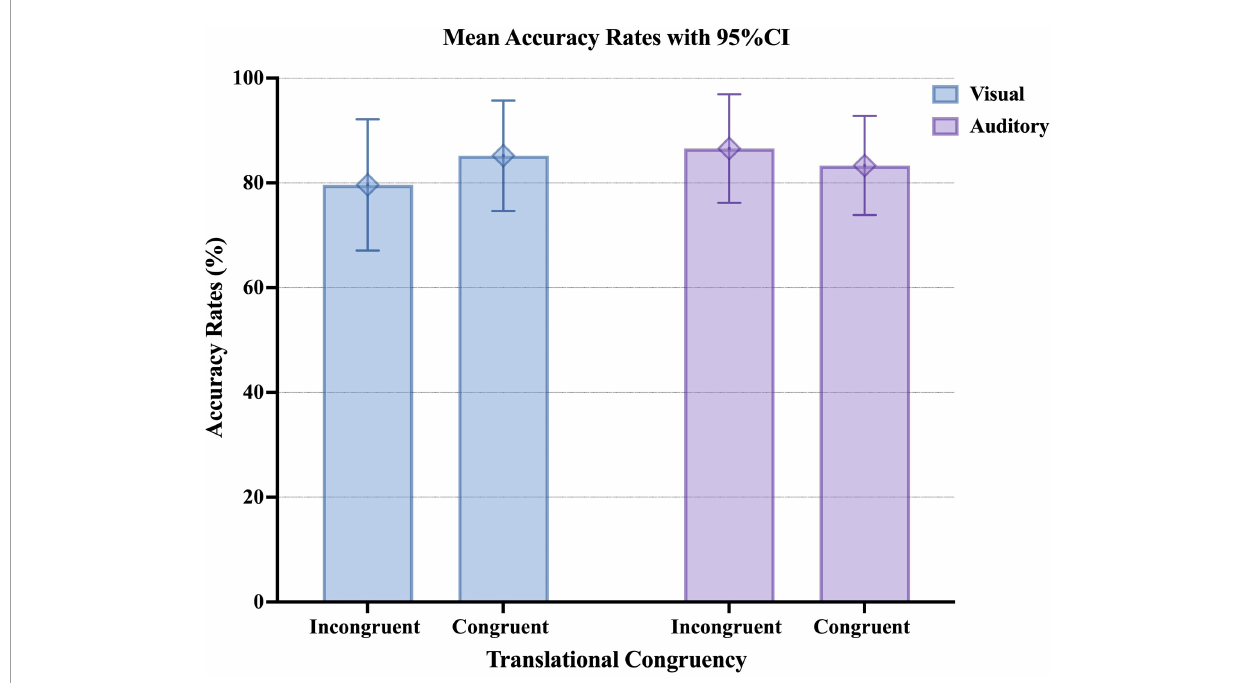
FIGURE5 Graph of the mean accuracy rates upon visual or auditory presentation of Japanese collocations with low semantic transparency and different translational congruency. The error bar shows the 95% CI.